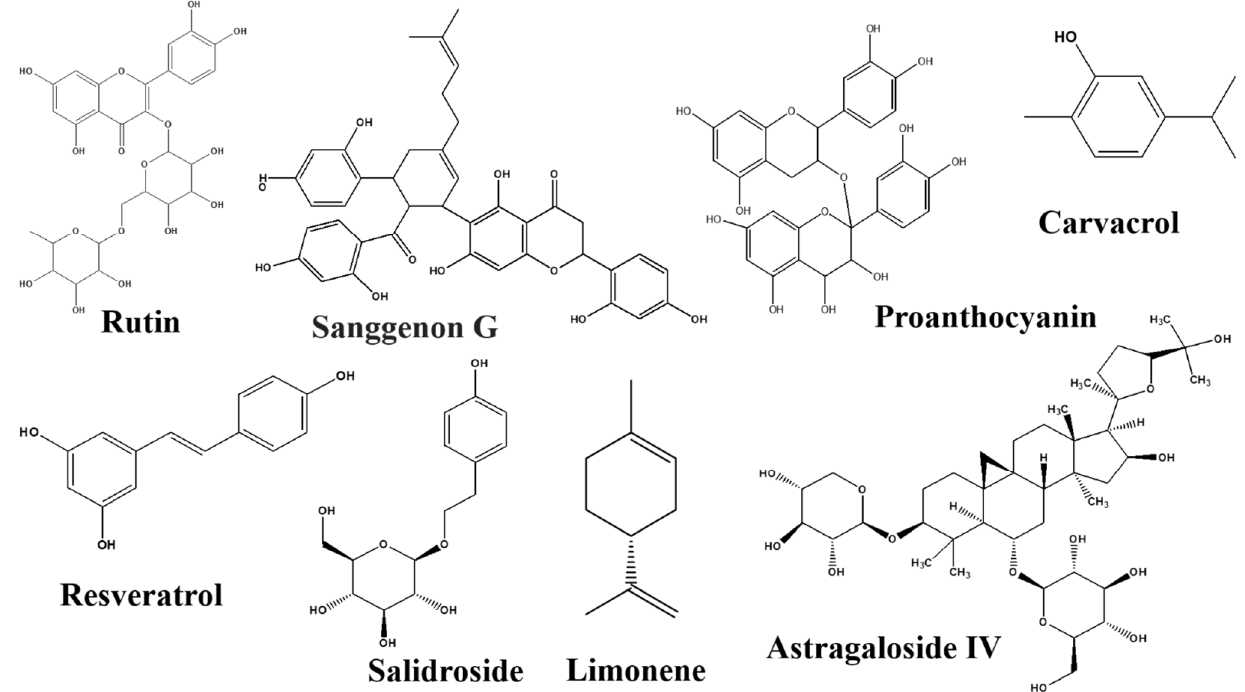
Figure 5. Structures of bioactive metabolites from natural products: Proanthocyanin— Cinnamomum zeylanicum ; Rutin— Fagopyrum esculentum ; Sanggenon G— Morus alba ; Salidroside— Rhodiola rosea ; Resveratrol— Polygonum cuspidatum ; Astragaloside IV— Astragalus membranaceus ; Carvacrol— Origanum vulgare ; Limonene— Citrus sinensis .